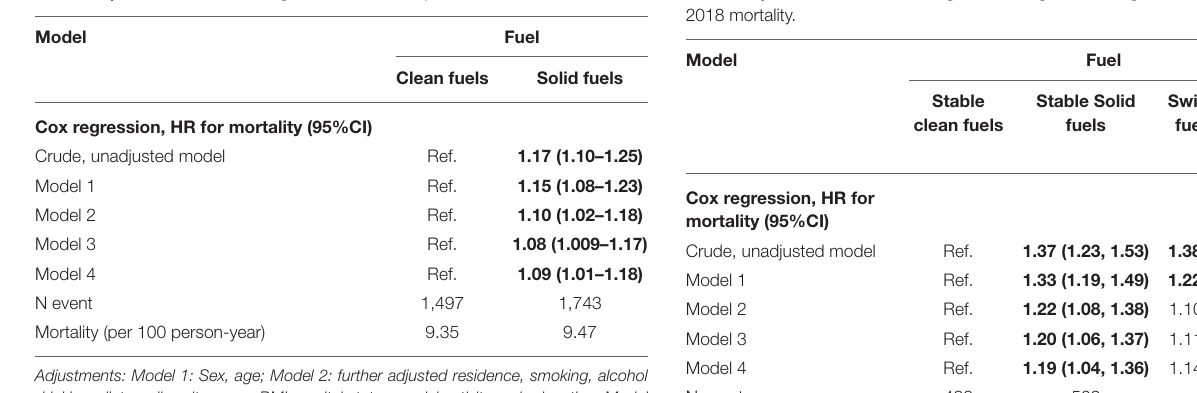
Stable Stable Solid Switching solid clean fuels fuels fuels to clean fuels